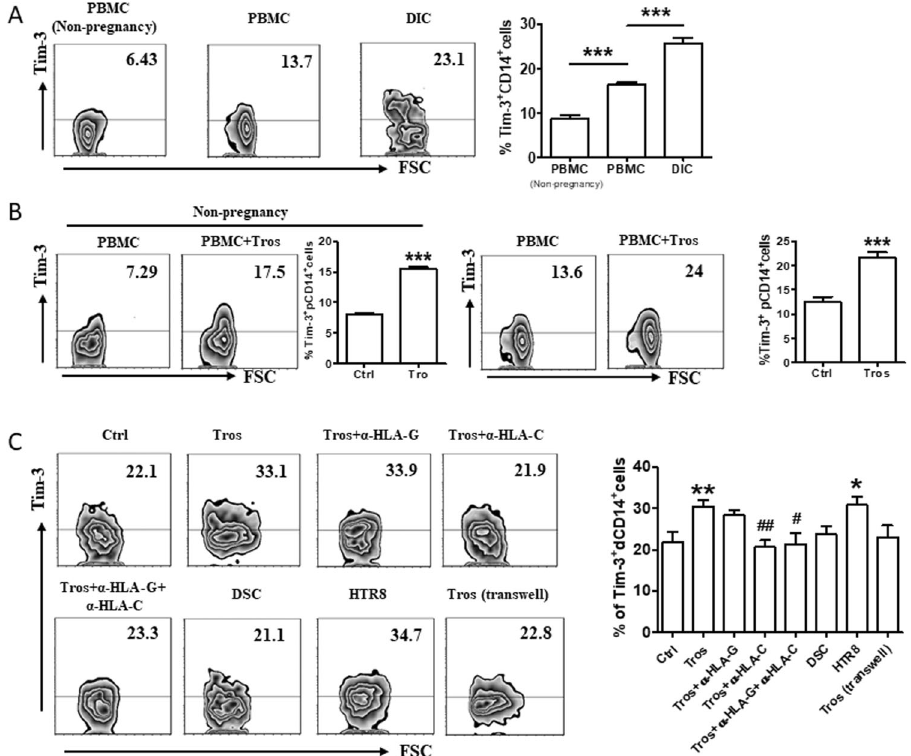
Fig. 1 Expression of Tim-3 on CD14 + cells during human early pregnancy. A Flow cytometric analysis and quanti fi cation of frequency of Tim-3 expression on gated CD14 + cells from peripheral blood mononuclear cells (PBMCs) isolated from non-pregnant women of childbearing age ( n = 9), and from paired PBMCs and decidual immune cells (DICs) during human fi rst trimester pregnancy ( n = 48). *** p < 0.001. B Quanti fi cation of fl ow cytometric analysis of Tim-3 expression on peripheral CD14 + (pCD14 + ) cells isolated from non-pregnant women or pregnant women, with or without co-culture with trophoblasts (Tros) for 48 h. n = 20. *** p < 0.001. C Quanti fi cation of fl ow cytometric analysis of Tim-3 expression on dCD14 + cells cultured alone or co-cultured with equal numbers of Tros (directly or indirectly), or decidual stromal cells (DSCs), or human HTR8/SVneo cells. The α -HLA-G/HLA-C antibodies were used in some wells. * p < 0.05, ** p < 0.01, compared with the control. # p < 0.05, ## p < 0.01, compared with the group co-cultured with Tros. Data represent the mean ± standard error of the mean (SEM). The fl ow cytometry plots are representative of three independent